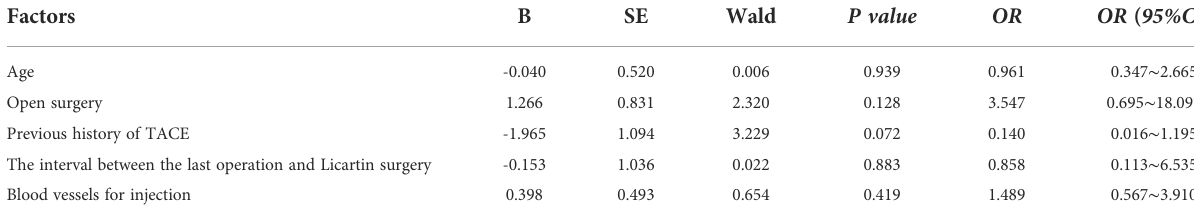
TABLE 3 Binary logistic regression analysis of factors resulting in the even Licartin distribution between the hepatic carcinoma area and to the normal liver tissue. Factors B SE